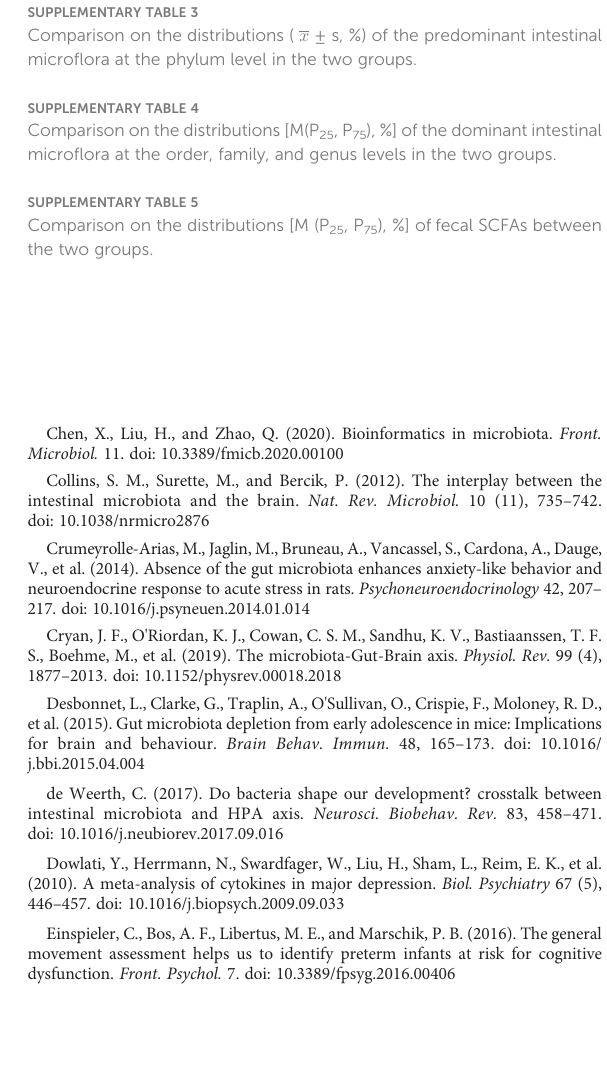
SUPPLEMENTARY TABLE 1 Comparison on MWM navigation test results of rats in the two groups. SUPPLEMENTARY TABLE 2 Comparison of the intestinal fl ora richness and diversity indexes ( x ± s) between the two groups. SUPPLEMENTARY TABLE 3 Comparison on the distributions ( x ± s, %) of the predominant intestinal micro fl ora at the phylum level in the two groups.